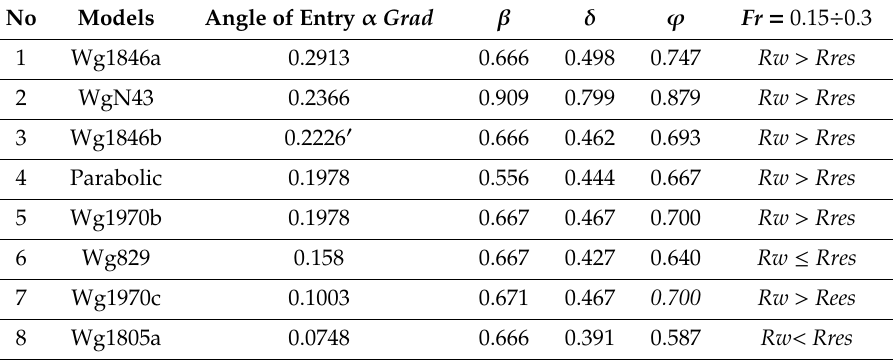
Table 1. Comparison of the relative position of the main part of the calculated Michel’s curves and the experimental curves of the residual resistance (Wigley’s